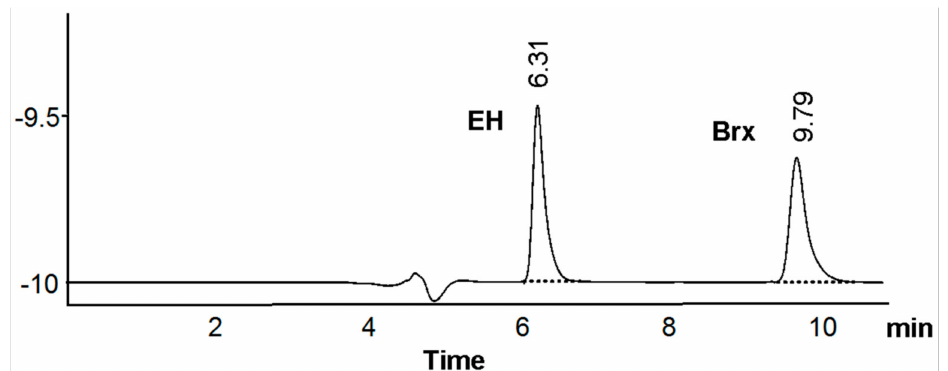
Figure 3. HPLC chromatogram of a working standard solution (0.1 mg/mL and 0.05 mg/mL for EH and Brx,